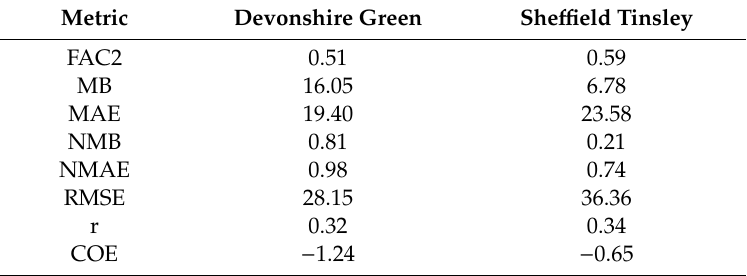
Table 7. The value of various statistical metrics used for assessing the performance of Airviro model for predicting NOx concentrations in the month of July 2017 at both Devonshire Green and She ffi eld